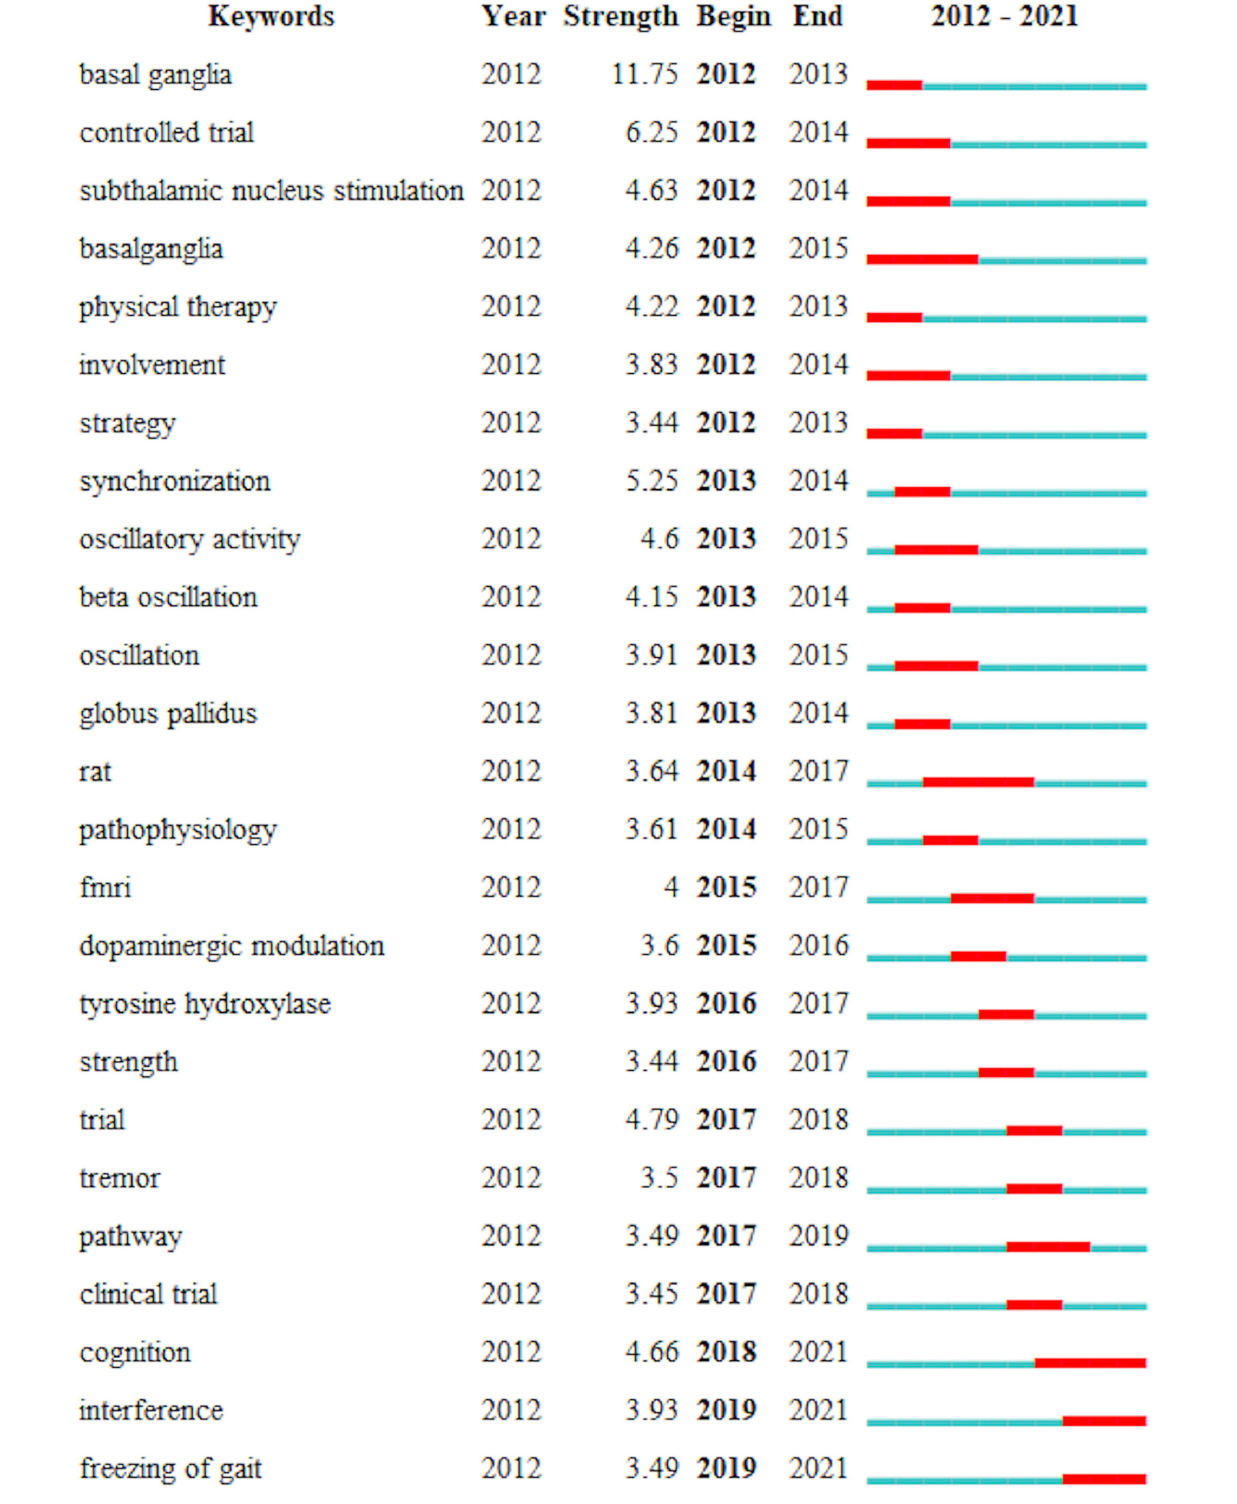
Frontiers in Human Neuroscience |